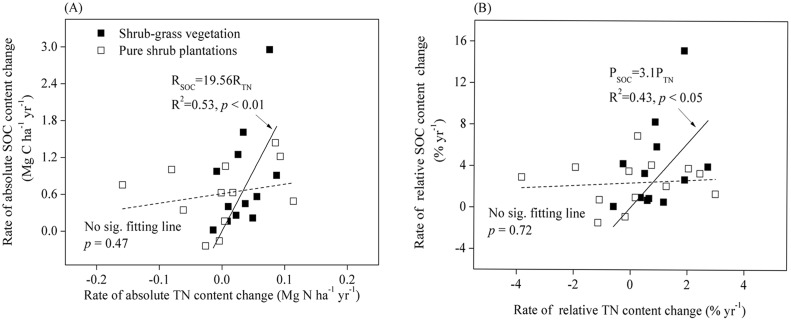
Patterns in SOC and TN content at 0–20 cm in shrub-dominated afforested sites.(A) Rates of absolute change in SOC and TN content; (B) Rates of relative change in SOC and TN content. The solid line indicates shrub-grass ecosystems and the dashed line indicates pure shrub plantations.